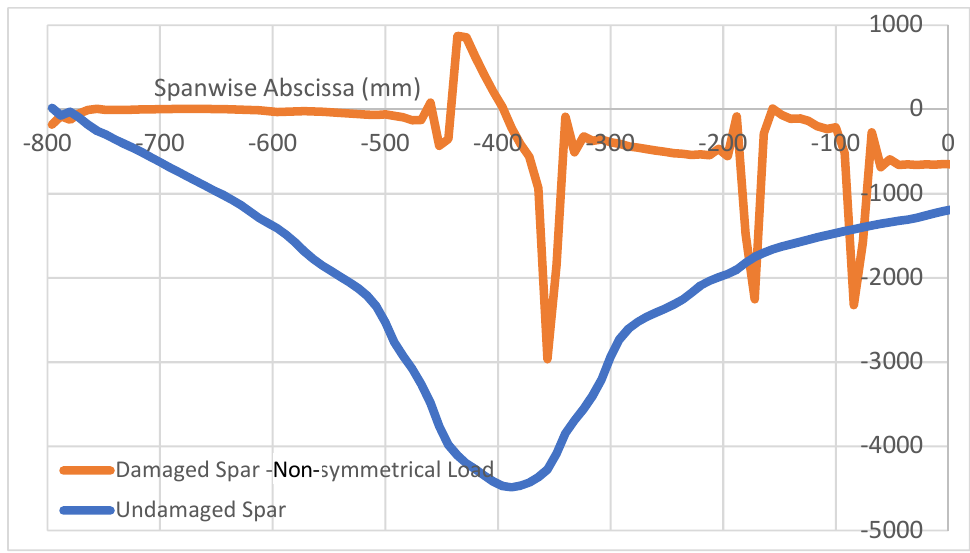
Figure 22. Effects of a 2-flaw array on the spar longitudinal deformation (με); non-symmetrical load.